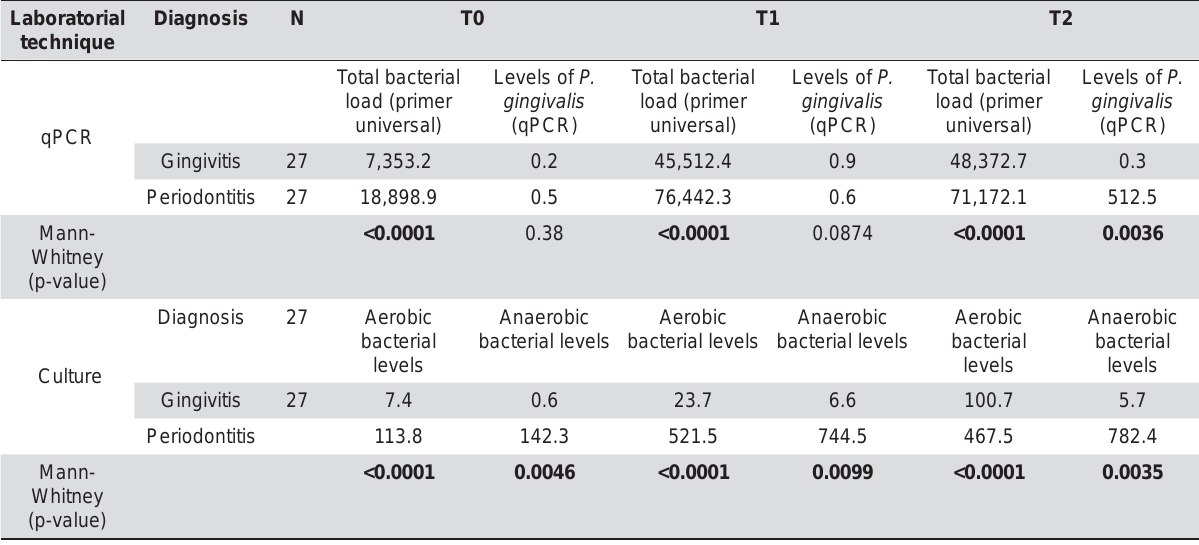
Table 2- Levels of bacteria (mean) according to laboratorial technique (qPCR and culture) before (T0), 2 (T1) and 6 minutes (T2) after dental scaling within a given periodontal